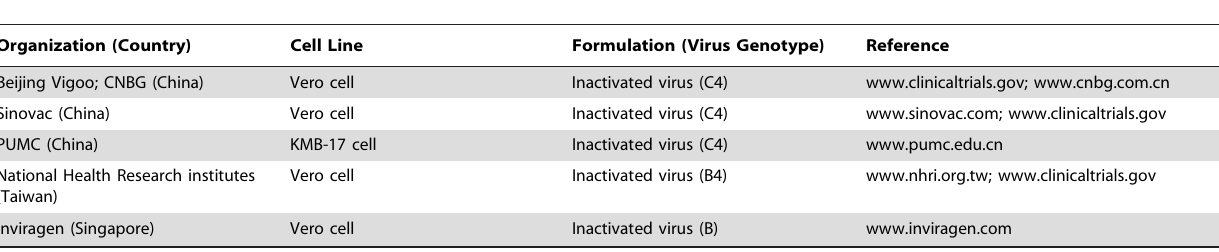
Table 7. EV71 vaccine candidates in clinical